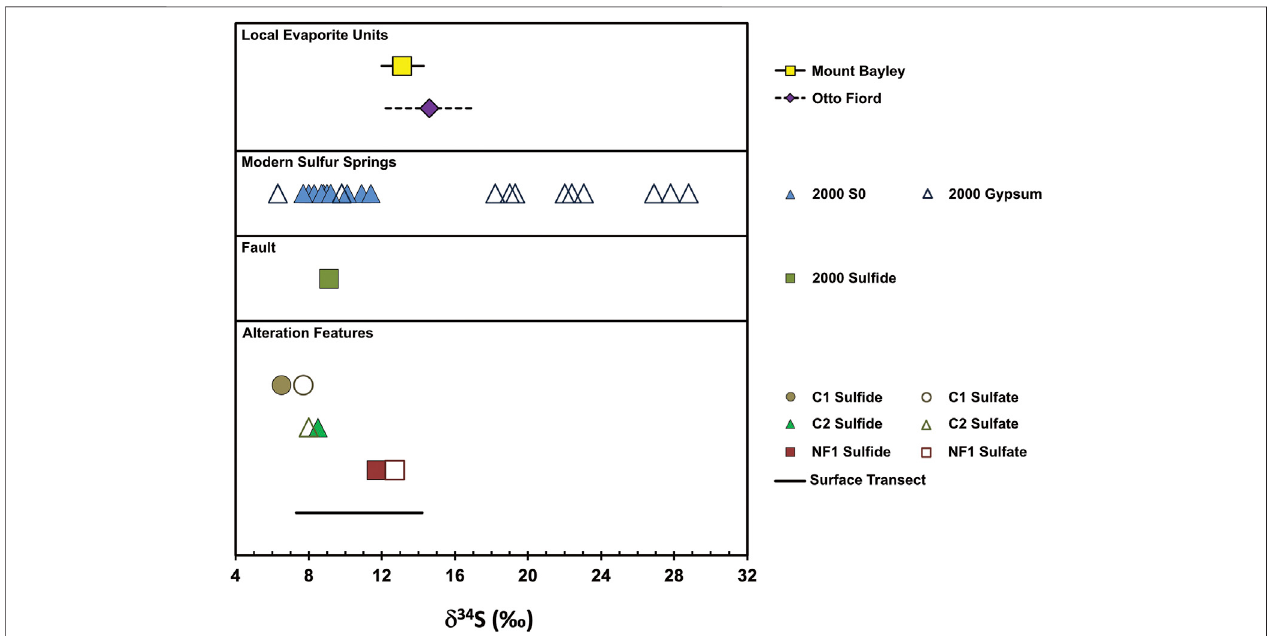
FIGURE3| Sulfurisotopes.Sulfurisotopesarereportedas δ 34 S( ‰ )againstV-CDT.Rangesof δ 34 SvaluesforanhydriteinlocalevaporiteunitsarefromtheMount Bayley Formation (reported in Wallace et al., 1994) and the Otto Fiord Formation (reported in Grasby et al., 2003); lines show ranges while average values are shown as fi lledmarkers.Datafordepositsofelementalsulfur(S0)andgypsuminthemodernspringsystemarefromsamplescollectedin2000asreportedbyGrasbyetal.(2003). The average δ 34 S of mineral sul fi des from the strike-slip fault (dotted line in Figure 1C ) are from samples collected in 2000 (Grasby et al., 2003). Isotope data for alteration feature samples include sul fi de and sulfates in core samples C1 and C2 as well as sample NF1. A range of δ 34 S values from S0 and gypsum from a surface transect reported by Grasby et al. (2012) are reported as a solid black line (ranges overlap; δ 34 S of S0 ranges from 7.4 to 14.2 ‰ , while δ 34 S of gypsum ranges from 7.3 to 13.0 ‰